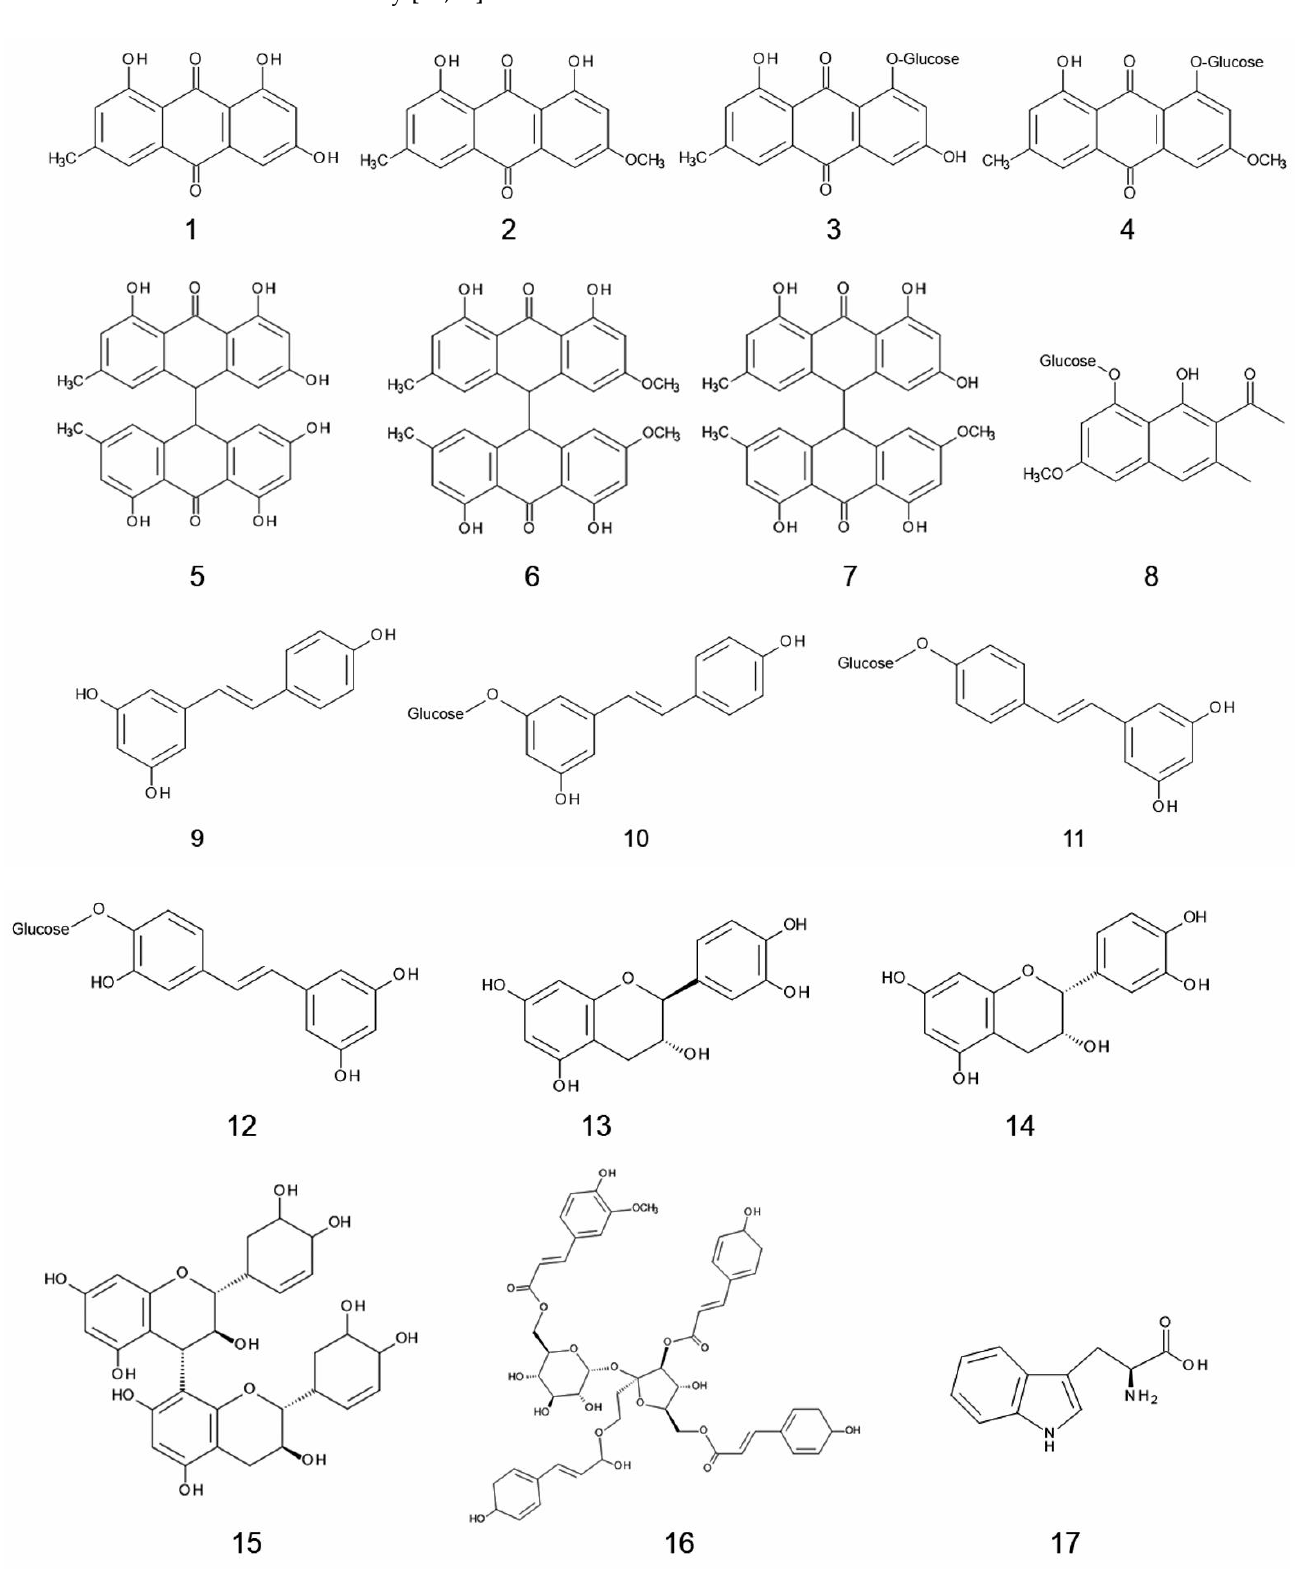
Figure 1. Allelochemicals identified in knotweeds. The numbering of chemical compounds is a continuation of the numbering given in Table 1.